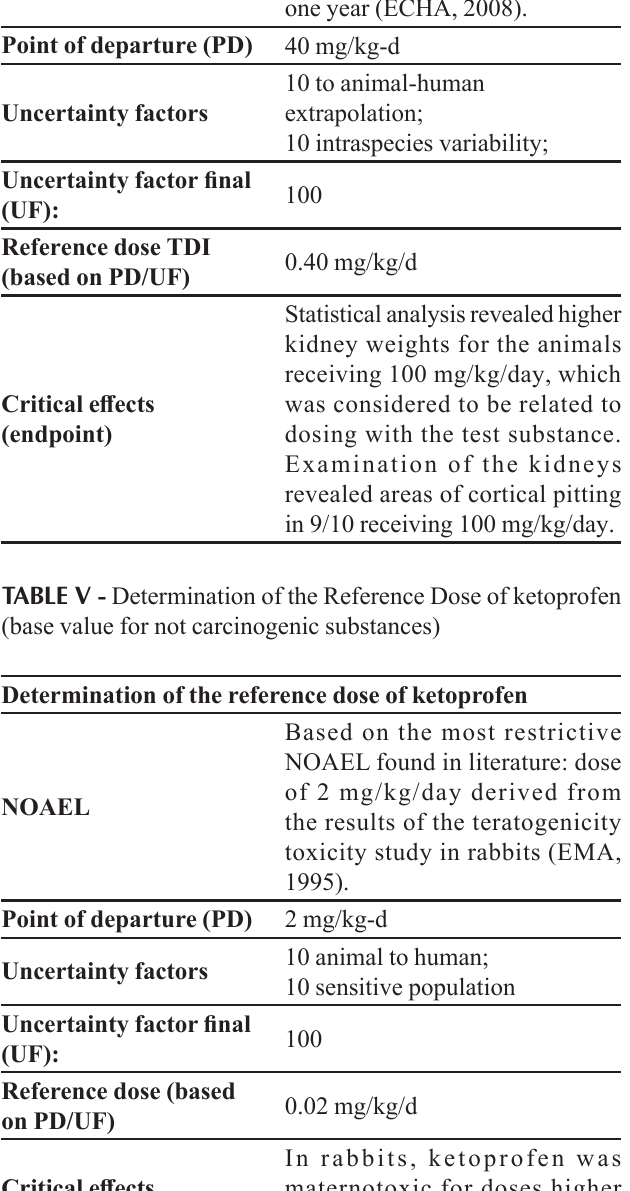
TABLE IV - Determination of the reference dose of ibuprofen (base value for no carcinogenic substances) Determination of the reference dose of ibuprofen NOAEL